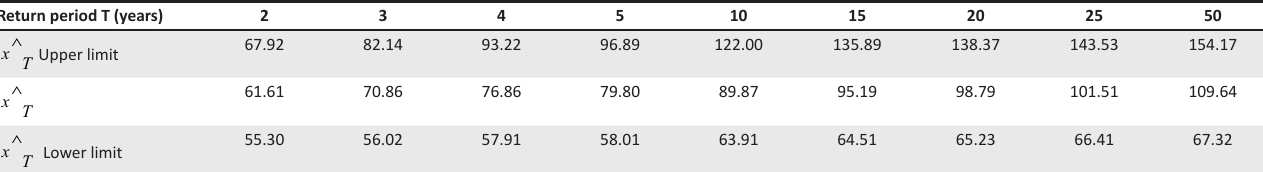
TABLE 8: Confidence intervals of estimated quantiles. Return period T